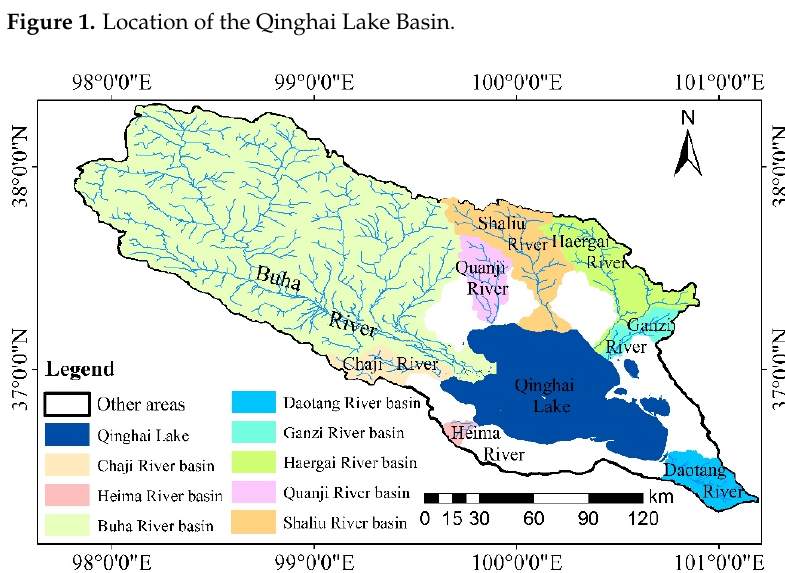
Figure 2. Distribution map of main river sub-basins in Qinghai Lake Basin.